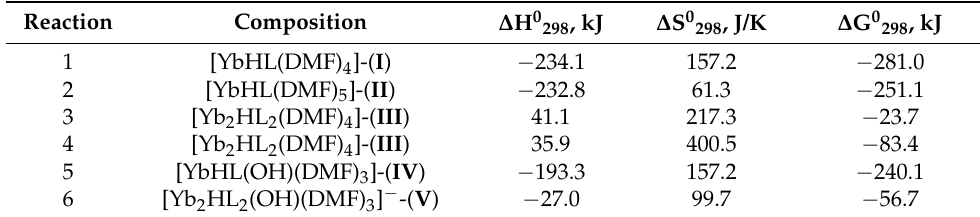
Table 2. The calculated thermochemical parameters ( ∆ H 0 298 , ∆ S 0 298 and ∆ G 0 298 ) of formation of complexes I – V with ligand H 4 L( 3 ) in the DMF solutions.